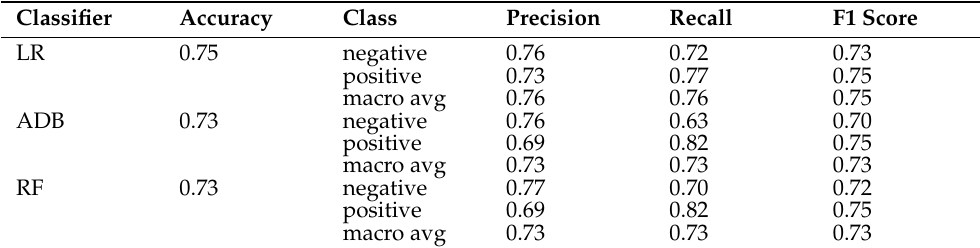
Table 7. Experimental results of ML models with original sentiments using TF-IDF.